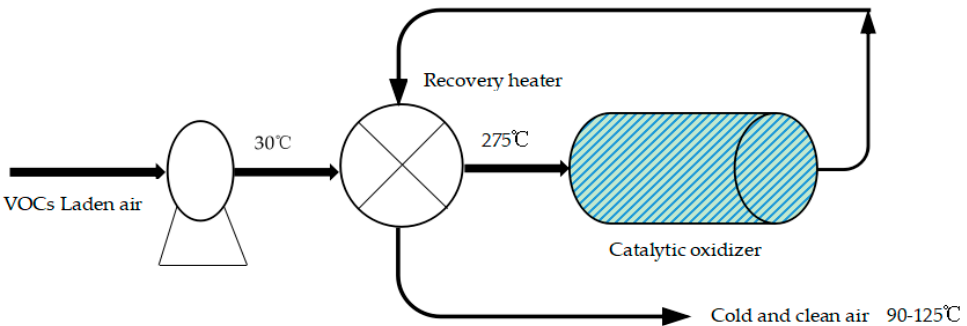
Figure 5. Scheme of catalytic oxidation. Reprinted with permission from [26], 2000, Elsevier Ltd.